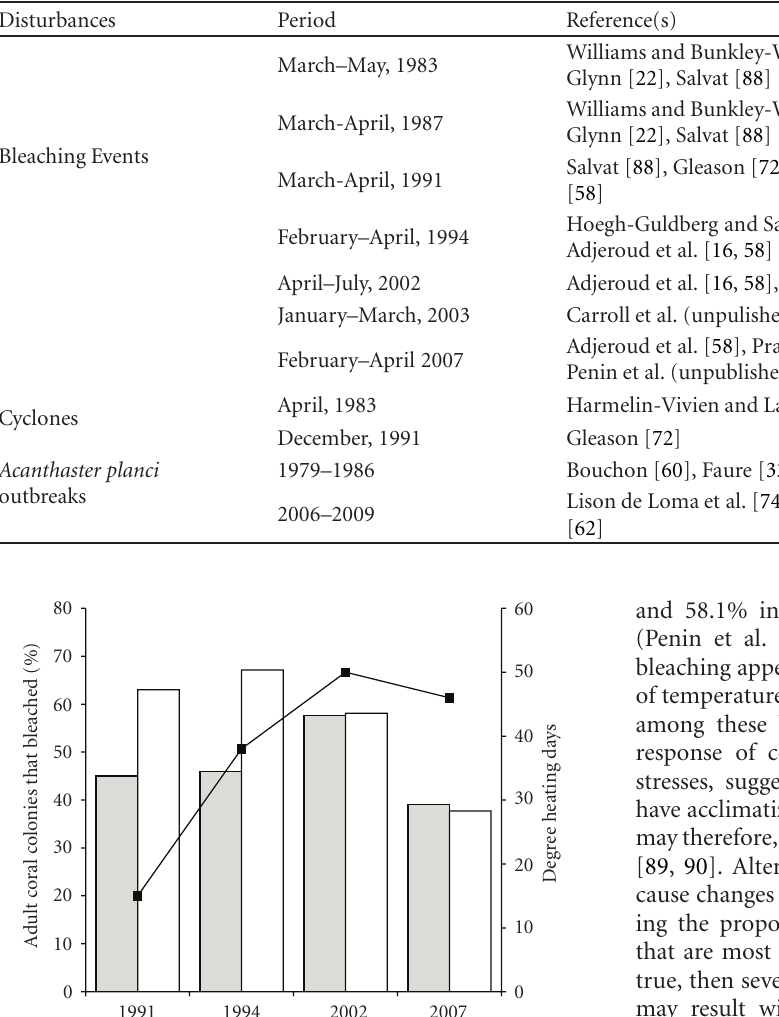
Figure 5: Percentage of adult coral colonies that bleached at Tiahura (grey bars) and Viaphu (white bars), versus the duration of temperature anomalies (degree heating days) during four episodes of mass-bleaching in Moorea. Degree heating days were calculated for the summer period (September–March) in each year that mass- bleaching was documented (generally between February and April), based on 4km Pathfinder (NOAA) data for Tiahura Reef with backfilling and smoothing functions to eliminate null